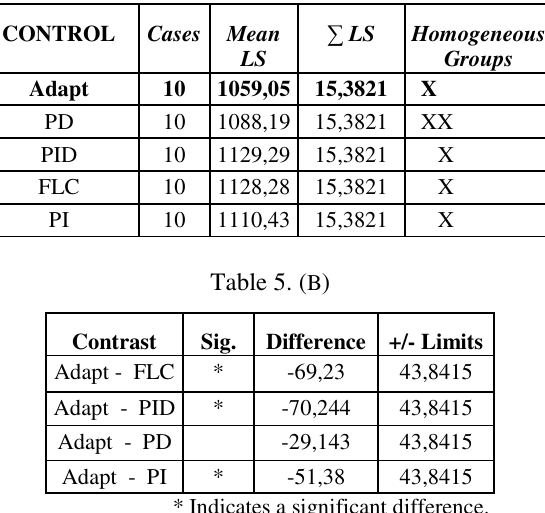
Table 4. ( B ) Method of 95,0% LSD for EC of CONTROL.